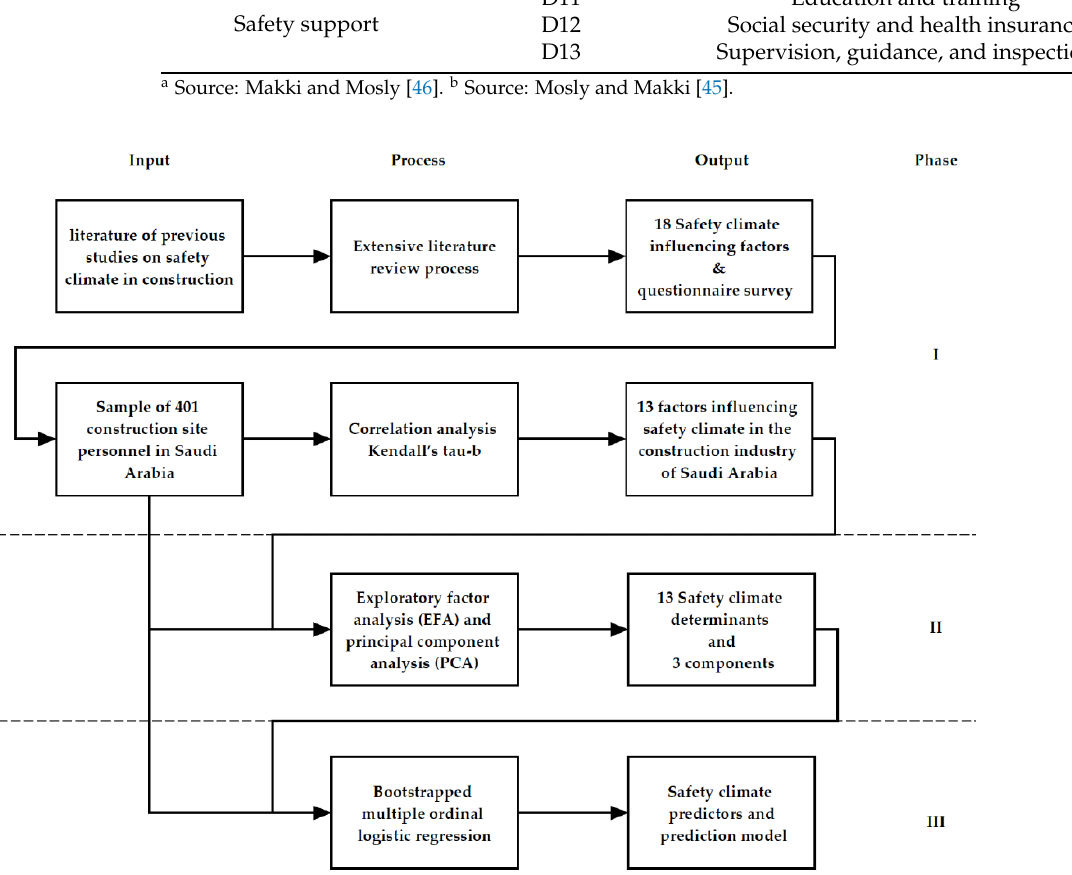
Figure 1. The research framework followed (Phase I: Mosly and Makki [45]; Phase II: Makki and Mosly [46]; and Phase III: the study herein).